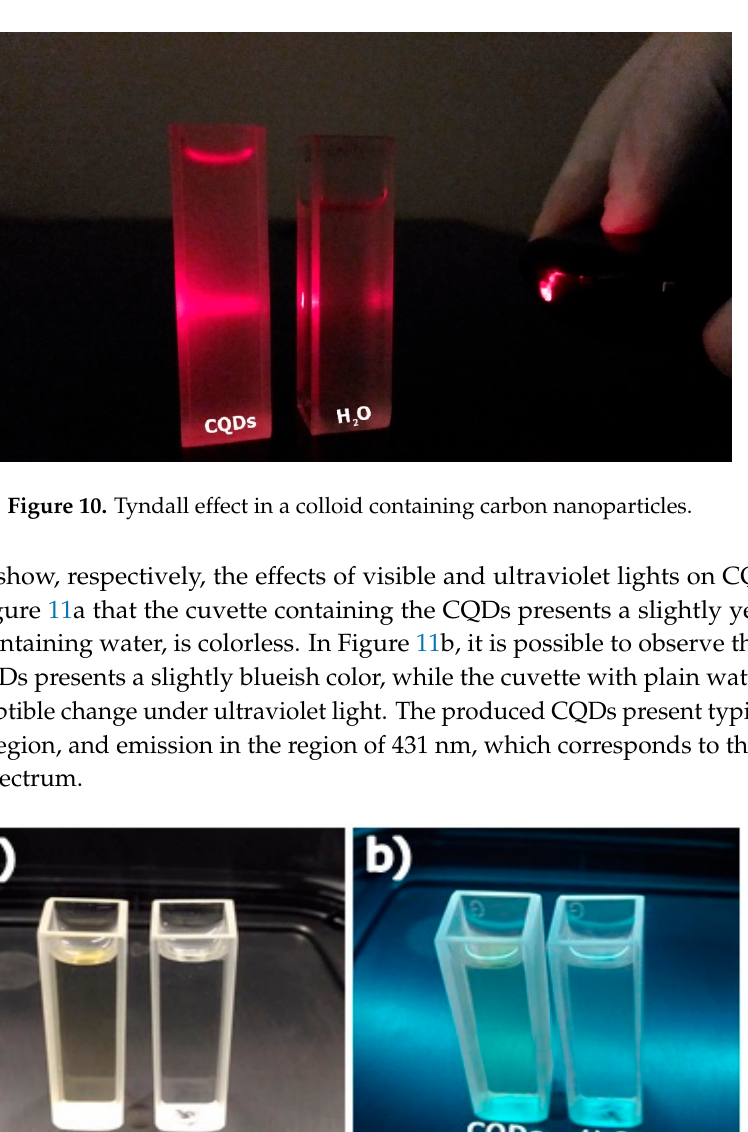
Figure 11. Previous characterization of CQDs. ( a ) Effect of white light on CQDs. ( b ) Effect of ultraviolet light on CQDs (254 nm).